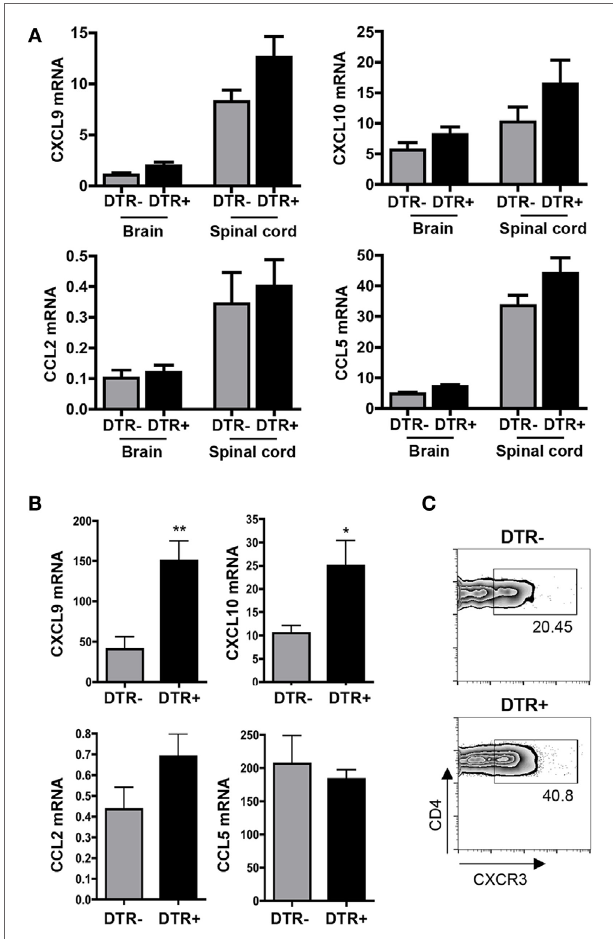
FigUre 6 | increased chemokine expression within cln of Foxp3 + Treg depleted mice . mRNA expression of CXCL9, CXCL10, CCL2, and CCL5 relative to GAPDH at d28 p.i., 1 week after DT treatment, in brain, and spinal cord (a) , and CLN (B) of DTR − and DTR + mice with n = 5–6 individual mice per group. * p < 0.05, ** p < 0.01, Mann–Whitney test. (c) Representative flow cytometry density plots depicting CXCR3 surface expression within CLN-derived CD4 + T cells in DT-treated DTR − and DTR + mice at d28 p.i. Data are representative of two separate